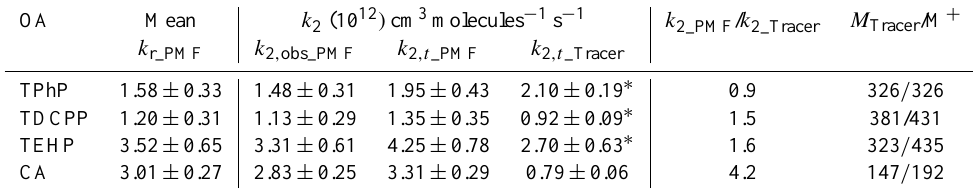
Table 1. Comparison of the measured k 2 values utilizing PMF and select m/z tracers, for organophosphate compounds and CA. OA